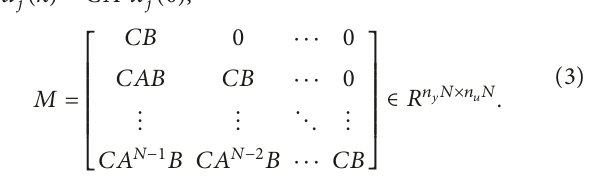
Figure 1: Basic ILC